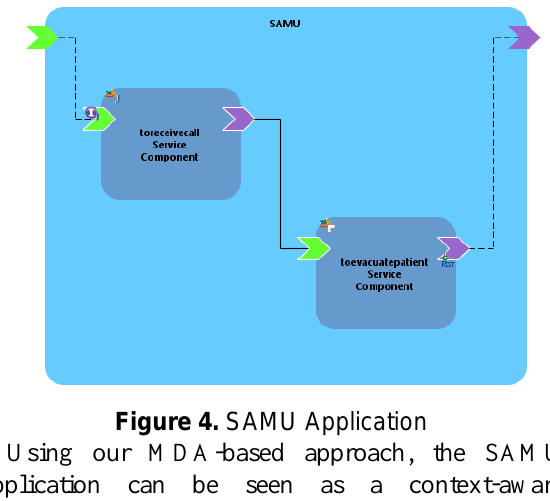
Figure 4. SAMU Application